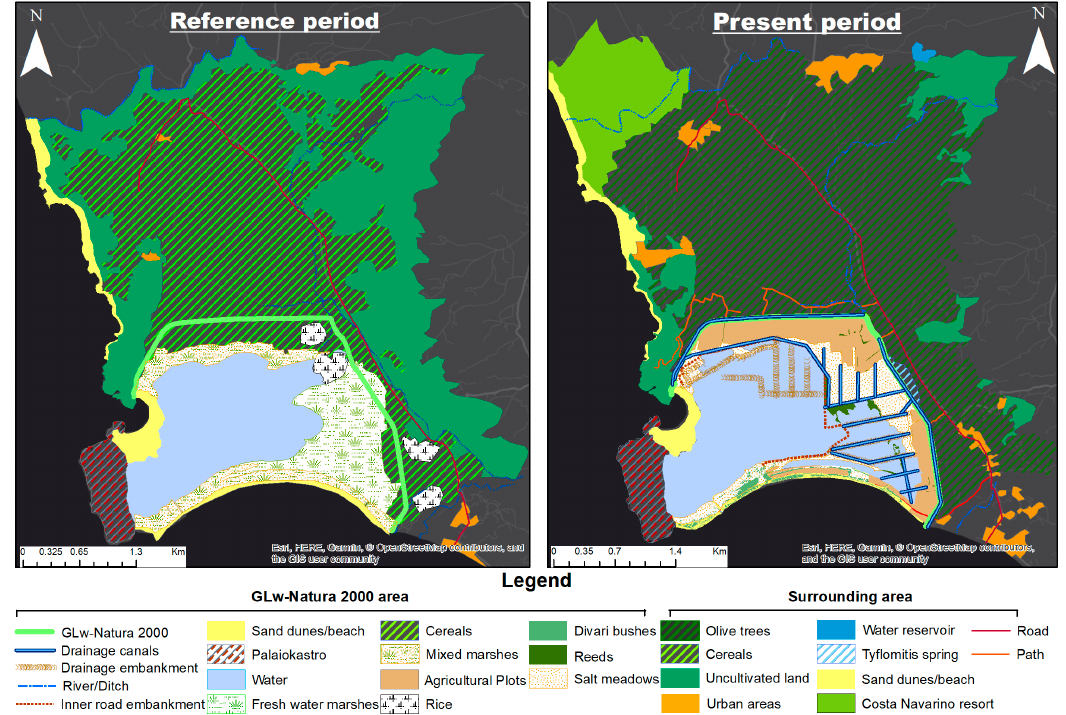
Figure 8. Land cover and major land uses in GLw-Natura2000 and the surrounding area in the past and present periods. The map of reference conditions was created in ArcGIS based on a 1945 b/w aerial photograph, interpretation of a historical map and interviews with the KIs. The map of present conditions was based on a 2010 Google Earth image and field observations in 2010 and 2018. The classification of the coverage of cereals (reference) and olive trees (present) in the surrounding area was based on the type of crop dominating the